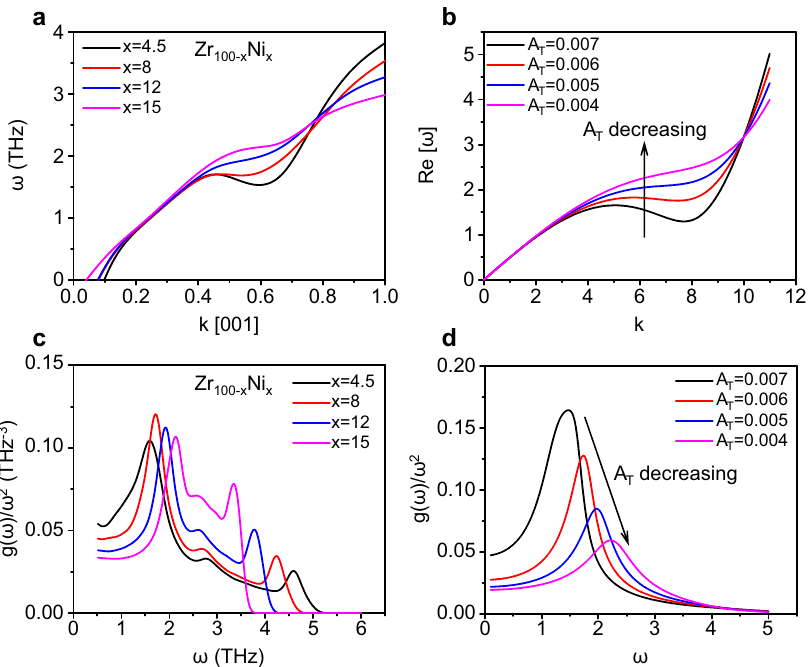
Fig. 6 Comparison of phonon dynamics obtained by simulation and the theoretical framework without assumptions of disorder. a [001] TA branches for different strain glass compositions ( x ) by simulation. b TA branches calculated by the Eq. (5). We set ν T = 0.5, D T = 0.012 and dial A T in the range of [0.004, 0.007]. B T changes with A T in the range of [0.000055, 0.000025]. c Reduced VDOS g ( ω )/ ω 2 vs. ω for different x by simulation. d Reduced VDOS g ( ω )/ ω 2 vs. ω according to the theoretical framework [Formula (3)]. We set k D = 11. The contribution of longitudinal acoustic branch is omitted